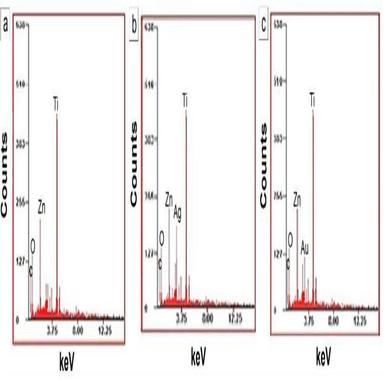
a) EDAX for ZnONPs/CS; b) ZnO,AgNPs/CS; c) ZnO, AuNPs/CS.